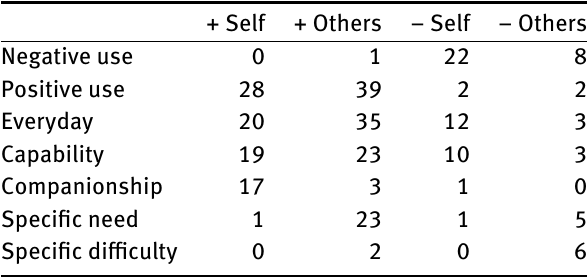
Table 9: Response by Category and Likert scale responses.